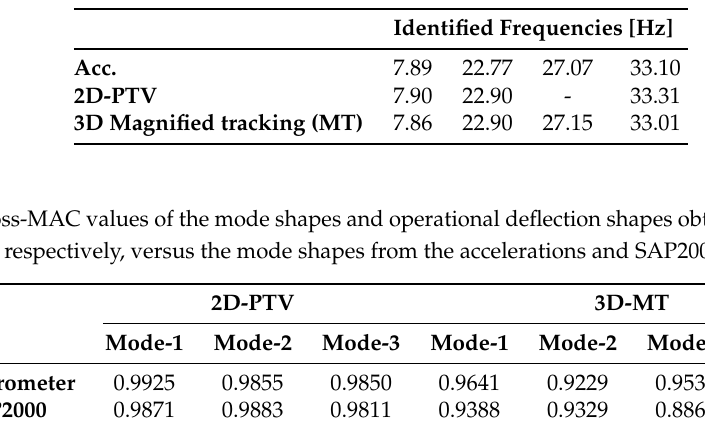
Table 2. Identified natural frequencies via different sensors and methodologies.